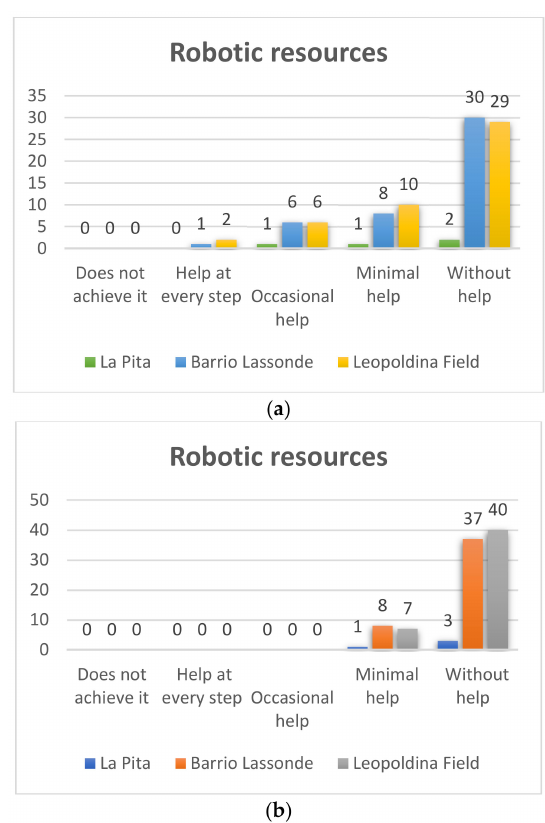
Figure 7. Kindergarden robotic resources Pre-Test ( a ) and Post-Test ( b